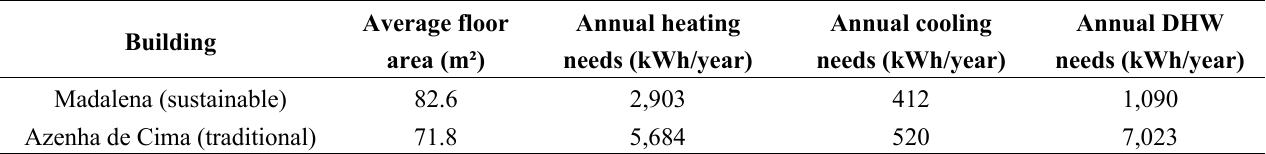
Table 4. Annual energy needs for the average dwelling—Madalena vs . Azenha de